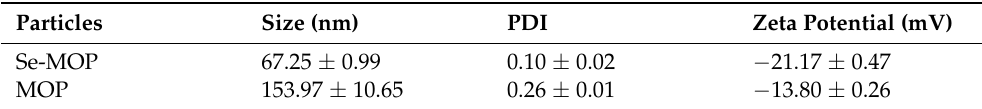
Table 1. Size, PDI, and zeta potential of Se-MOP and MOP. Data from three separate experiments are expressed as means ± SD in triplicate.